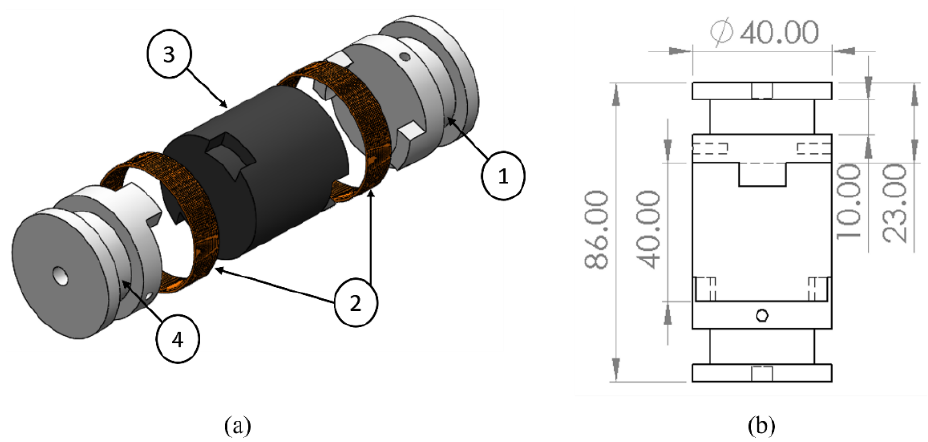
Figure 5. ( a ) Exploded view: 1—upper coupling hub; 2—coils; 3—MRE-layer; 4—lower coupling hub; ( b ) drawing view of MRE-based coupling (unit: in mm)